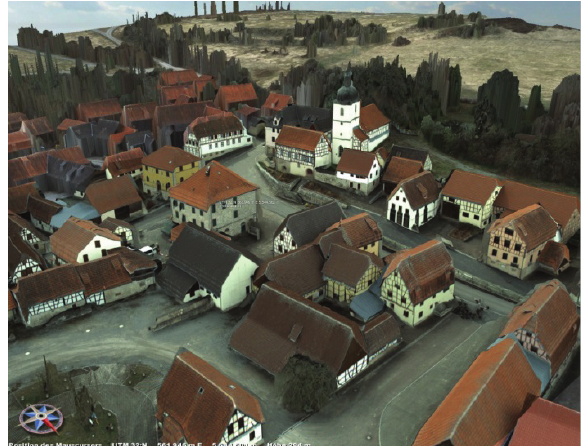
Figure 15. Screenshot of interactive